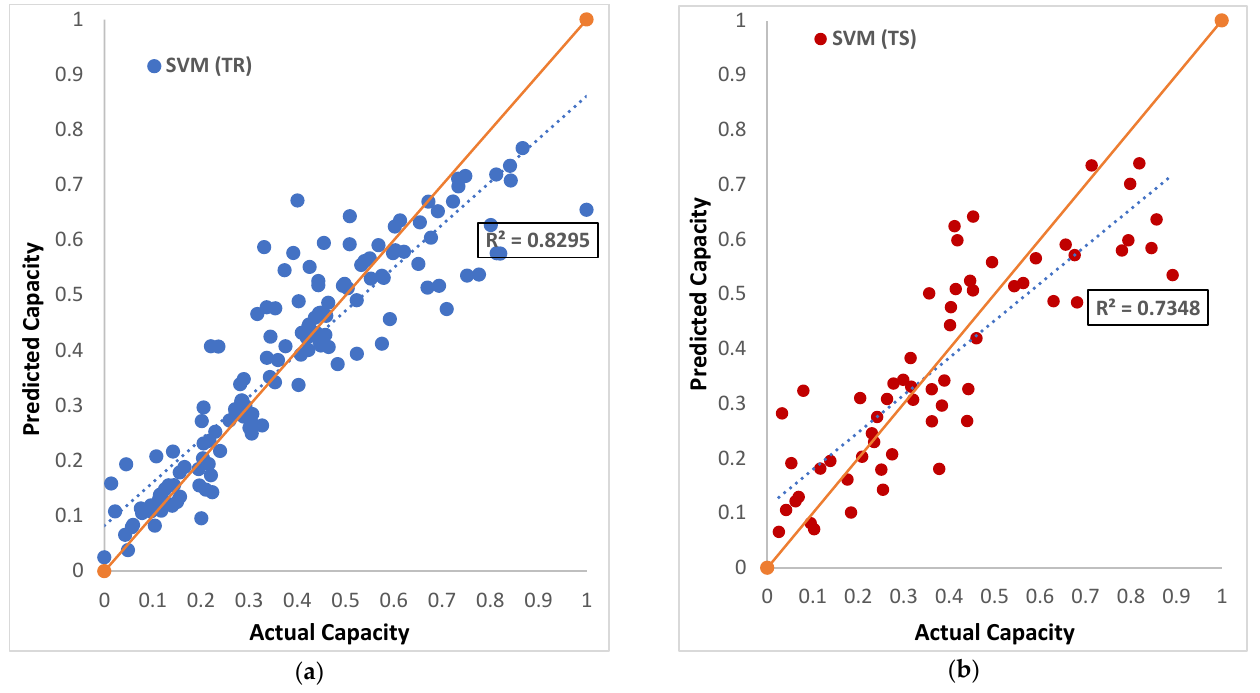
Figure 9. Trend for actual capacity and predicted capacity for SVM model: ( a ) training data; ( b ) testing data.